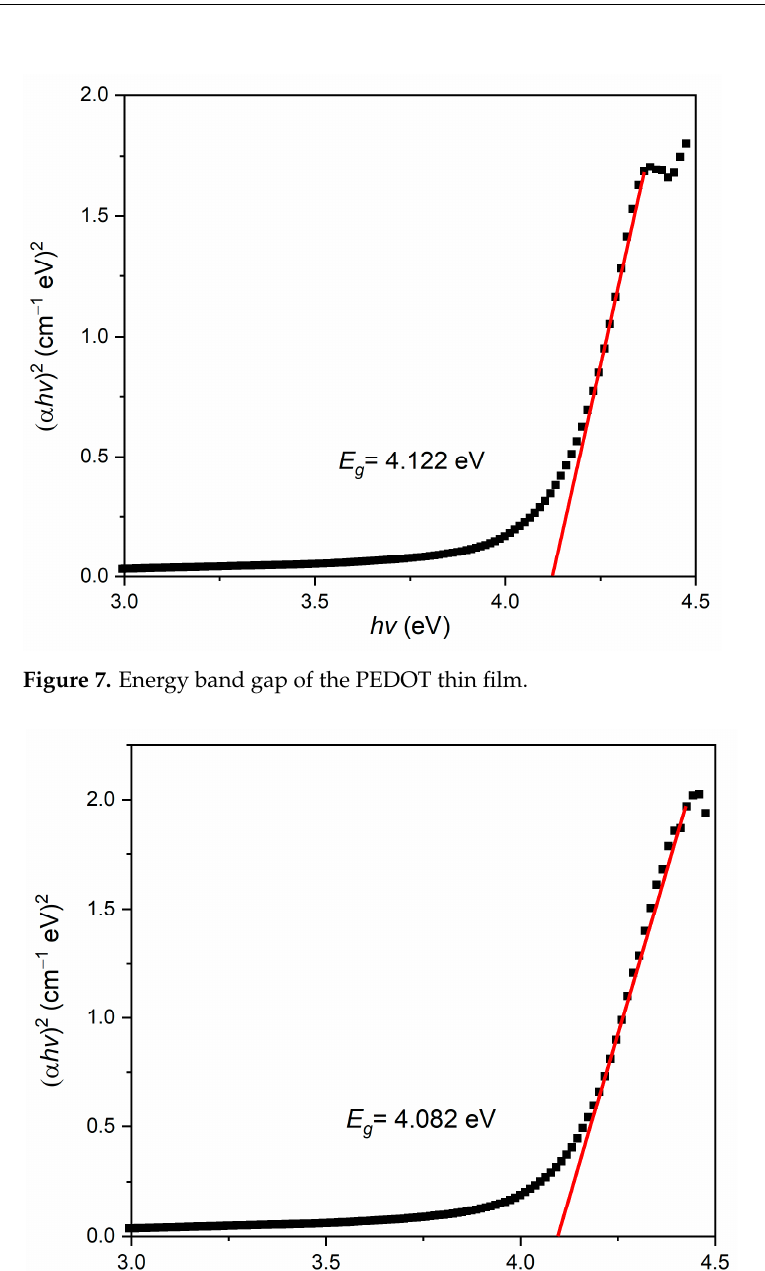
Figure 6. Energy band gap of the NCC thin film.